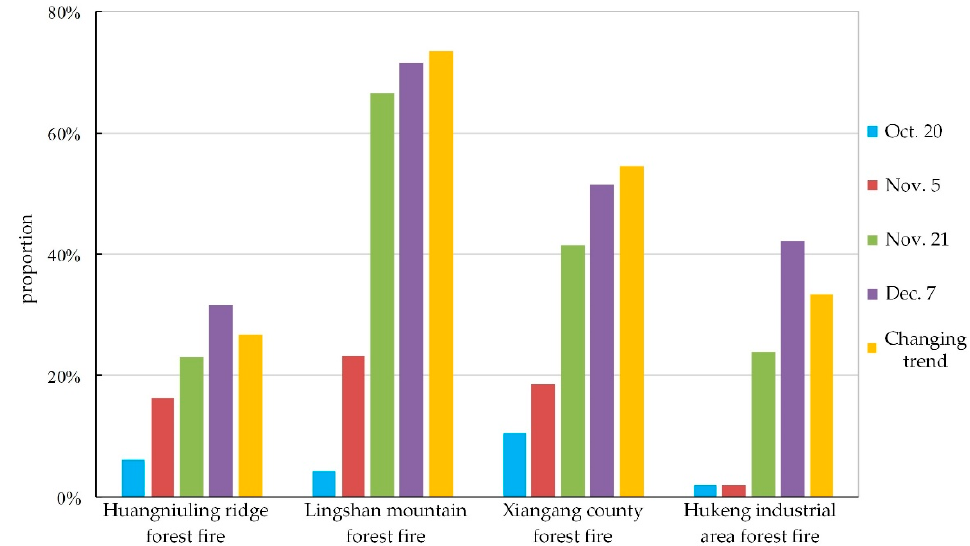
Figure 8. The proportions of high forest fire risk and increasing trend in forest fire risk in the areas of four fire events.